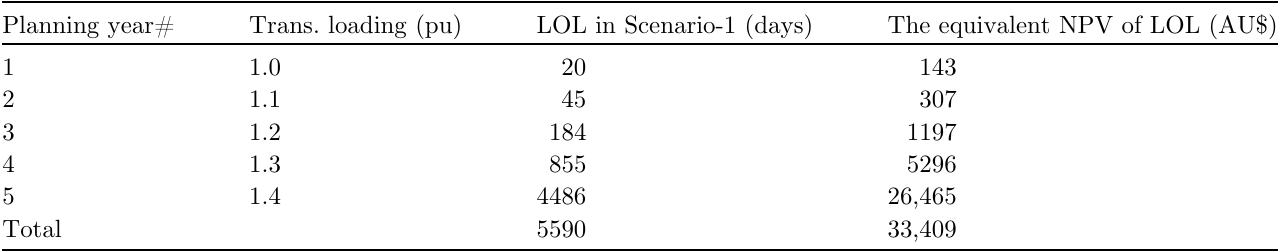
Table 2. Loss of life (LOL) of the considered distribution transformer and the corresponding equivalent cost in Scenario- 1 at all years of planning.